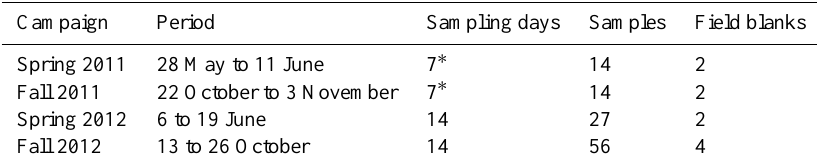
Table 1. Monitoring experiments conducted for this study. Campaign Period Sampling days